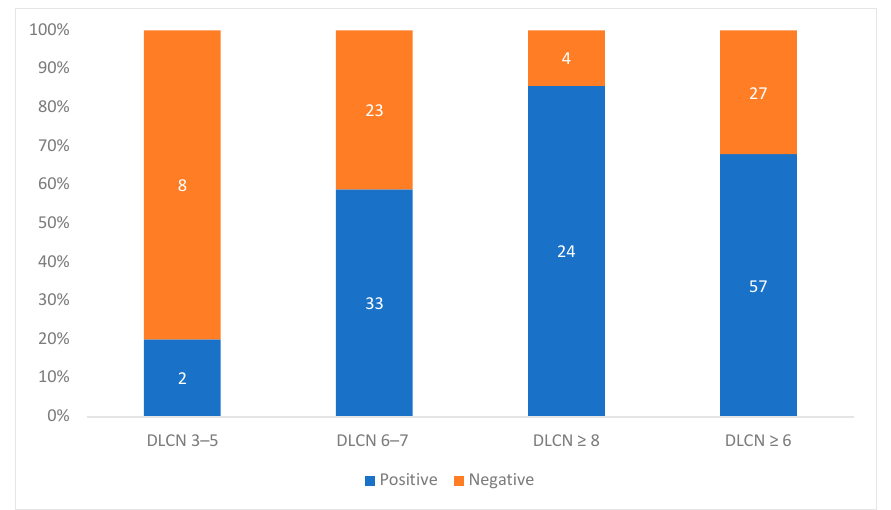
Table 3. Genetic testing results.